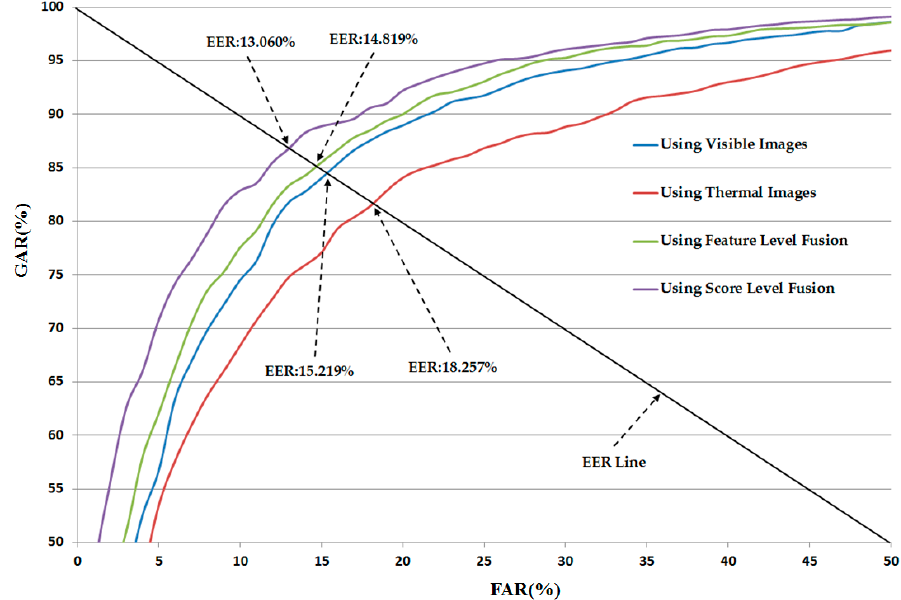
Figure 8. Average ROC curve of our proposed method for gender recognition using different kinds of images and combination methods.